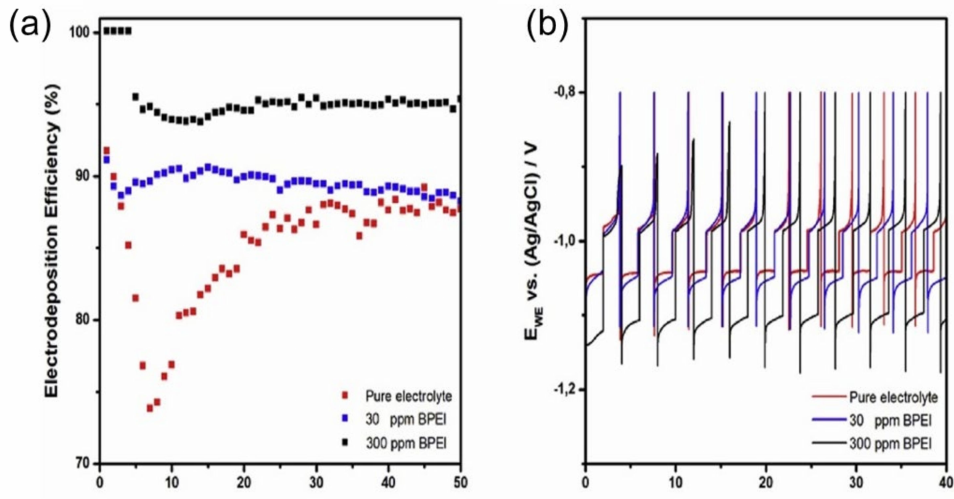
Figure 6. ( a ) Zinc electrodeposition efficiency upon 50 cycles without BPEI, and with 30 and 300 ppm of BPEI as an additive in 0.5 M of ZnSO 4 . ( b ) Potential variation of the working electrode during zinc deposition and dissolution in different solutions. Reprinted with permission from Ref.